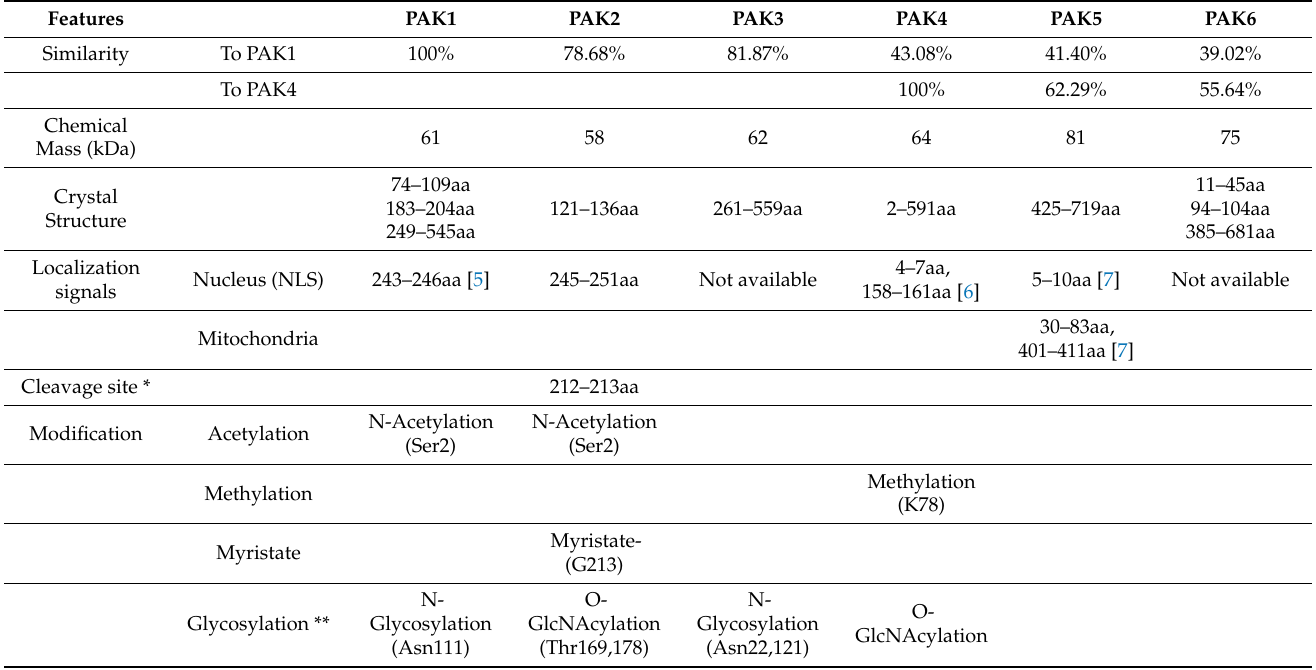
Table 1. Molecular features of